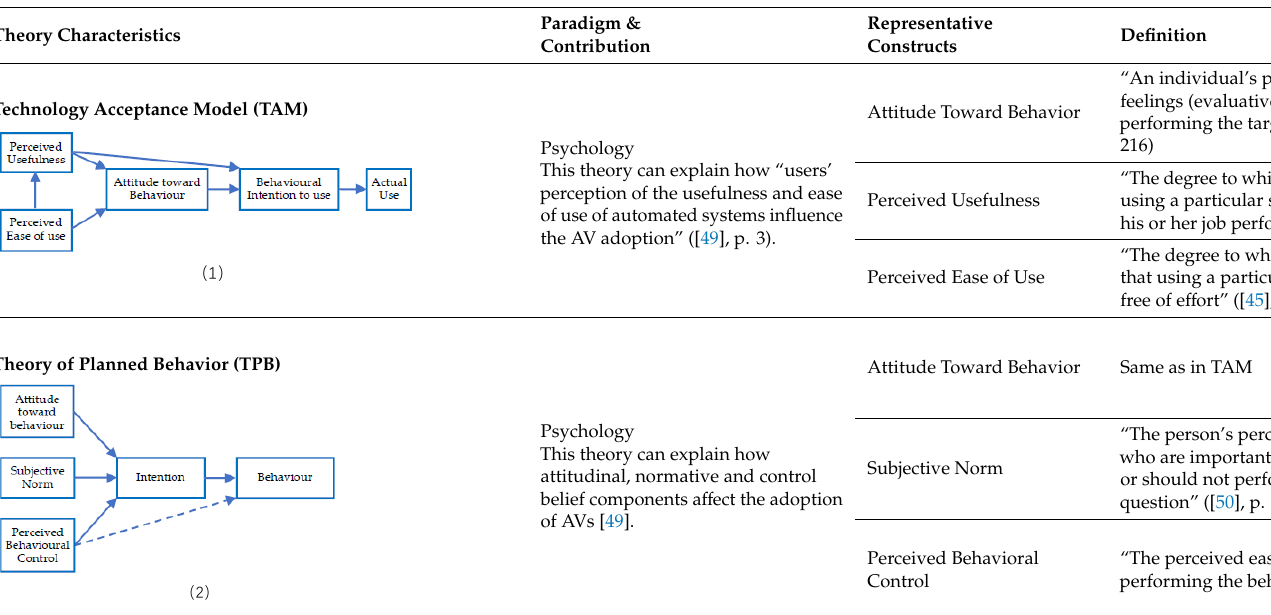
Table 1. Summary of the most common technology acceptance theoretical models (Source: Authors).